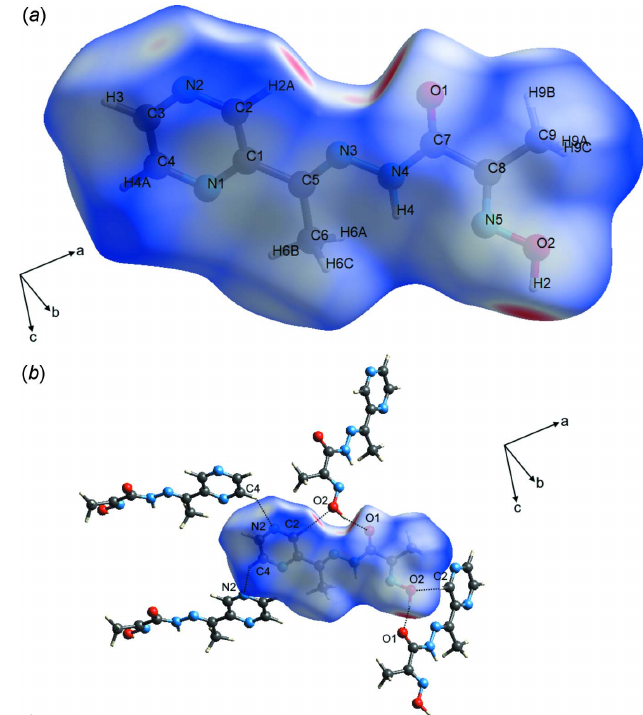
Figure 3 The Hirshfeld surface of the title molecule 1 mapped over d norm , showing the close contacts.